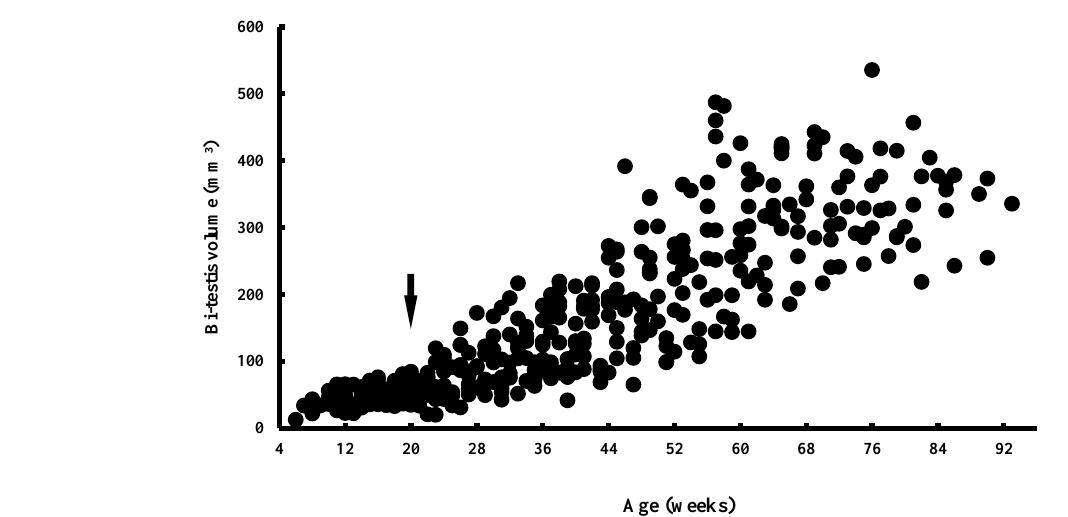
Figure 3. Bi-testis volume of the individual common marmosets ( n = 48). Note the homogenous testis volume until the 20th week (5 months) of age (arrow), while highly variable individual testicular volume was observed after the 24th week (6 months) of age.